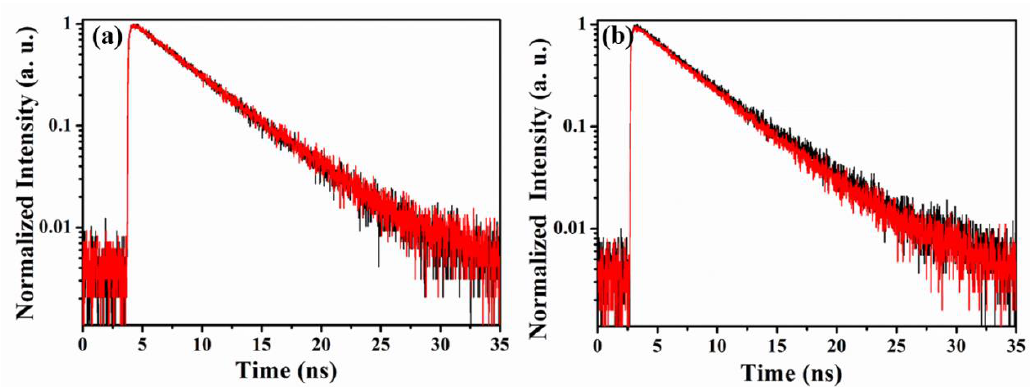
Figure 6 . ( a ) Time-resolved fluorescence of riboflavin with (red) and without Ag nanoparticles (black). ( b ) Time-resolved fluorescence of iLOV-W83A with (red) and without Ag nanoparticles (black).